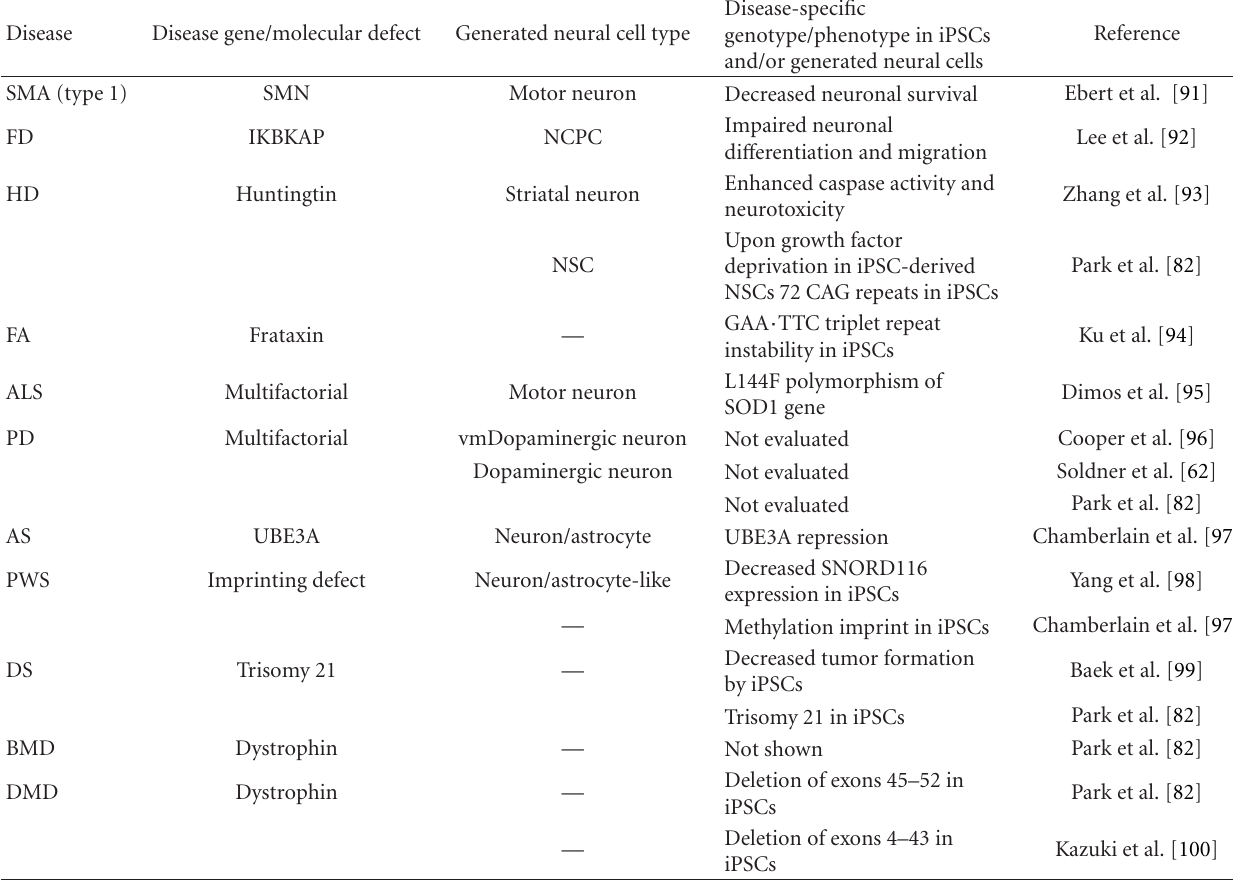
Table 1: Patient-specific pluripotent stem cells in neurological